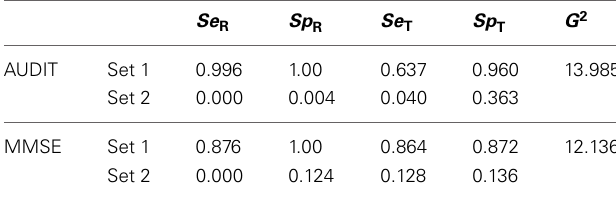
Multitree for Model 2, IR, in the two examples with real